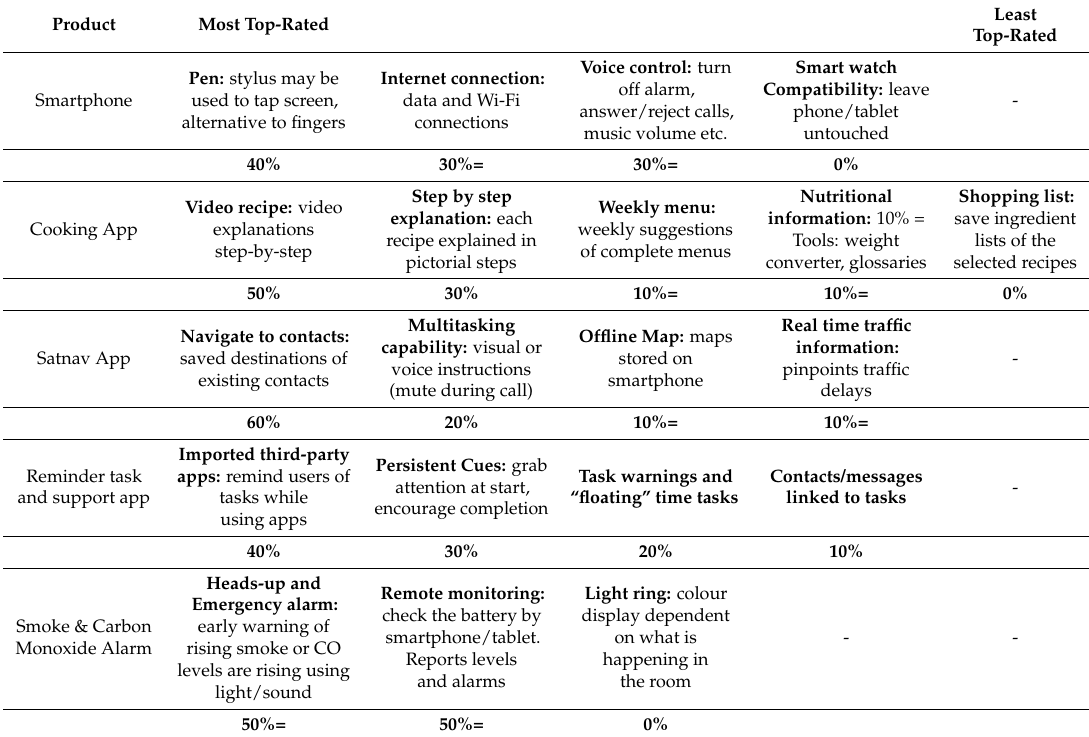
Table 5. Non-paired product features ordered by frequency of top-rating by the carers ( n = 10).